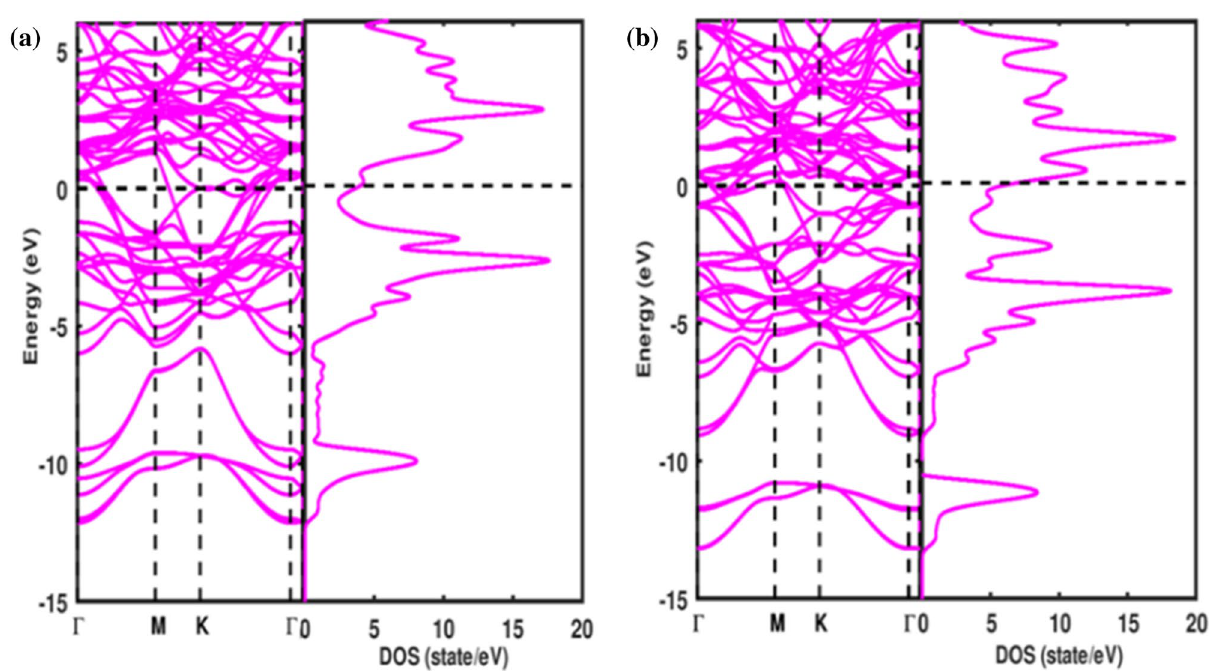
Figure 2. Band structures and TDOS of ( a ) Ti 3 SiC 2 , ( b ) Ti 3 AlC 2 MAX phase